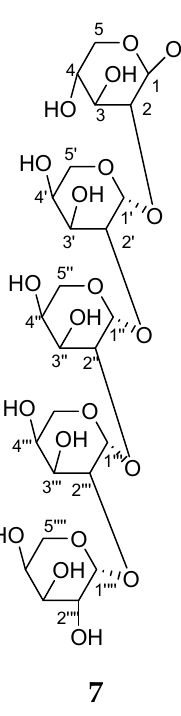
Figure 3. Chemical structure of compounds 5 – 7 .